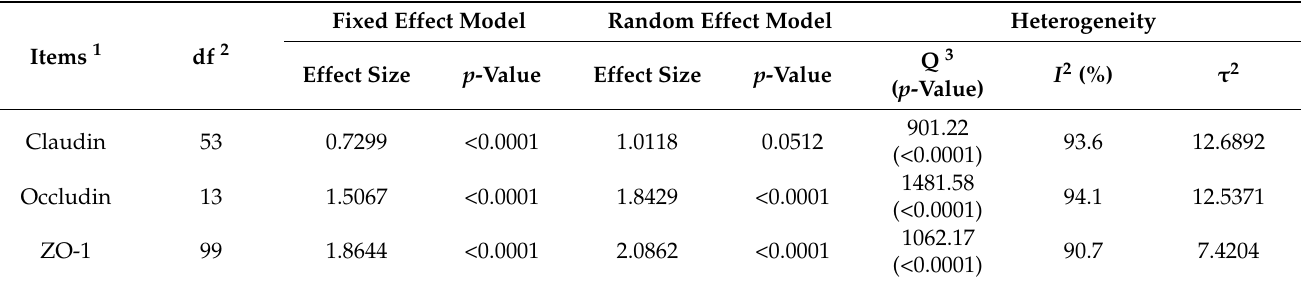
Table 6. Trimmed effect size of probiotics on the tight junction protein expression of intestinal tracts in the animal